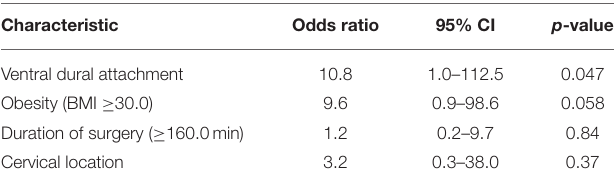
TABLE 5 | Multivariate binary logistic regression analysis of predictors of CSF fistula after surgery for spinal meningioma. Characteristic Odds ratio 95% CI p -value Ventral dural attachment 10.8 1.0–112.5 0.047 Obesity (BMI ≥ 30.0) 9.6 0.9–98.6 0.058 Duration of surgery ( ≥ 160.0min) 1.2 0.2–9.7 0.84 Cervical location 3.2 0.3–38.0 0.37